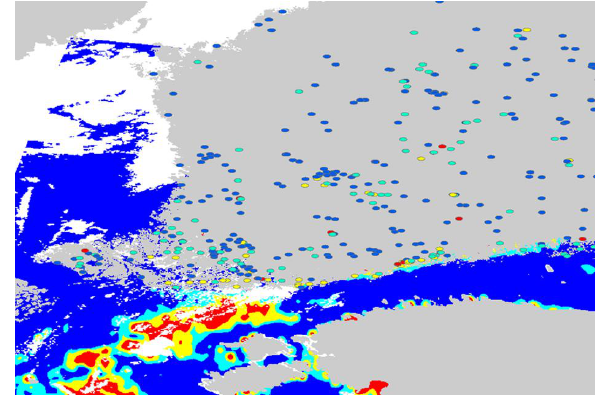
Figure 3: Citizen observations mapped on top the surface algal bloom product by the Finnish Environment Institute from summer 2011 based on MERIS